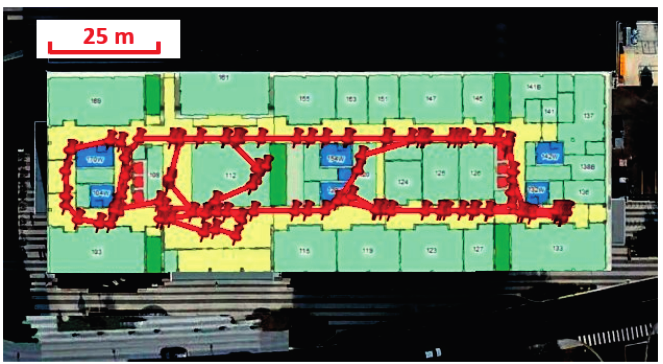
Figure 9. WiFi fingerprinting result at EEEL.